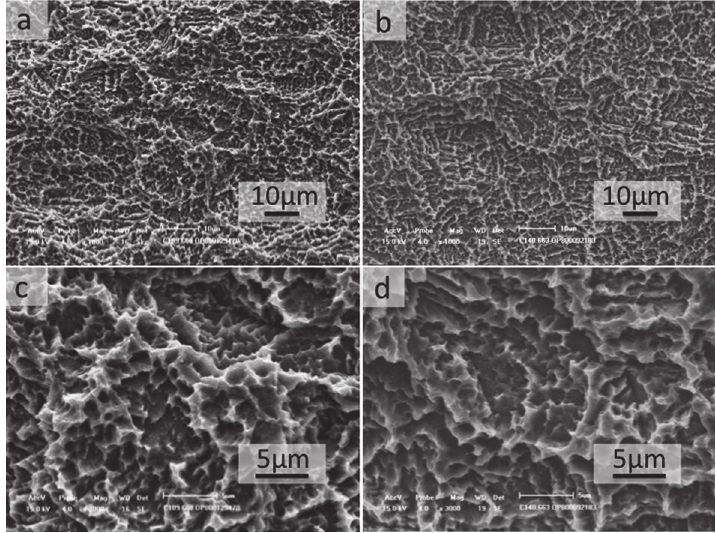
Figure 1- Scanning electron microscopy of implants surface. Group 1 (a and c) and Group 2 (b and d). No difference between the groups was observed. A and B (original magnification 1,000X) and C and D (original magnification